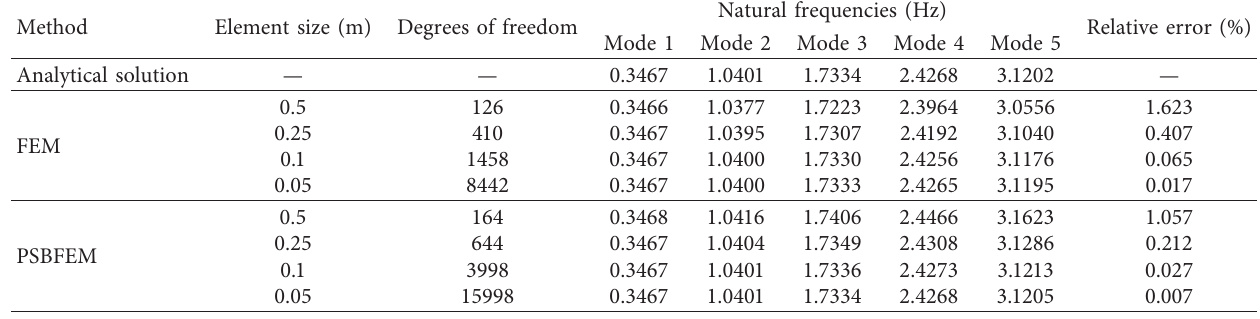
Table 1: The first five natural frequencies (Hz) of a horizontal soil foundation.